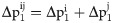
The cost of rising entropy in the PFC.(a) Entropy changes ΔH as a function of marginal probability changes Δp1ij=Δp1i+Δp1j in the case of GO correct trials. Changes were computed between +0.5 s and -1 s from stimuli onset. Each dot corresponds to a neuron pair. The linear regression is shown in red, and efficiency E is defined as the slope if the regression (slope = 0.97, 95% CI = [0.85,1.09], assessed by bootstrapping). (b) Efficiency dynamics along GO and NOGO trials. Efficiency increases as soon as the stimuli is presented in the case of GO trials whereas no differences were observed in the NOGO case (E values and CI are shown). (c) Surrogate pairs were built by changing only the p11 values observed during stimulus presentation (no changes were made for basal p11, p1i and p1j values, neither for p1i and p1j values during stimulus presentation). The scheme represents two pairs of neurons, composed of neurons i and j, and neurons k and l. Each pair has its p11 (full length of the arrow) and its pind (length till black dot). Additionally, each pair has its f value, which is the quotient between the observed p11 and the pind. Surrogates are then constructed by exchanging f values and multiplying the original pind with the f value of the other pair, thus obtaining a surrogate p11 value (p11surr). Only f values of pairs belonging to the same session were permuted. (d) Assessing the role p11 in efficiency. A thousand surrogate values of E were generated by changing the probability of coincidence p11 as described in (c) in order to build the null distribution P(Es). Efficiency measured from our data (E = 0.975) is significantly higher than the expected by chance (P = 0.021).